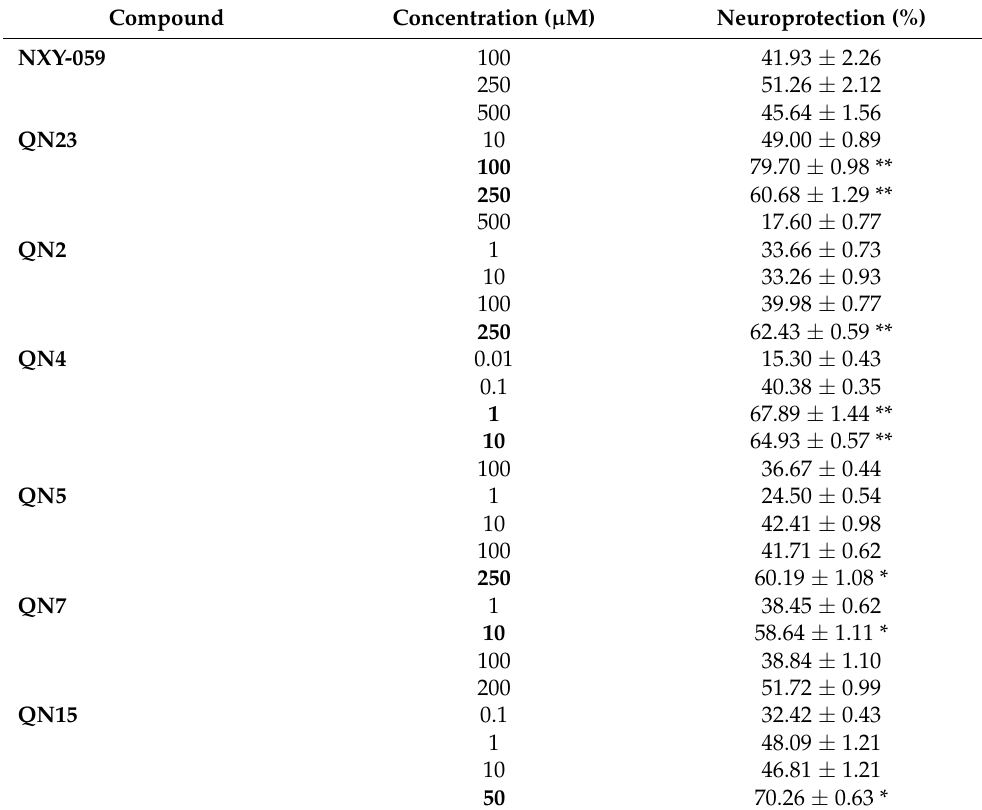
Table 2. Neuroprotective activity for NXY-059, QN23 and the most neuroprotective QNs, in neuronal cultures exposed to OGD a